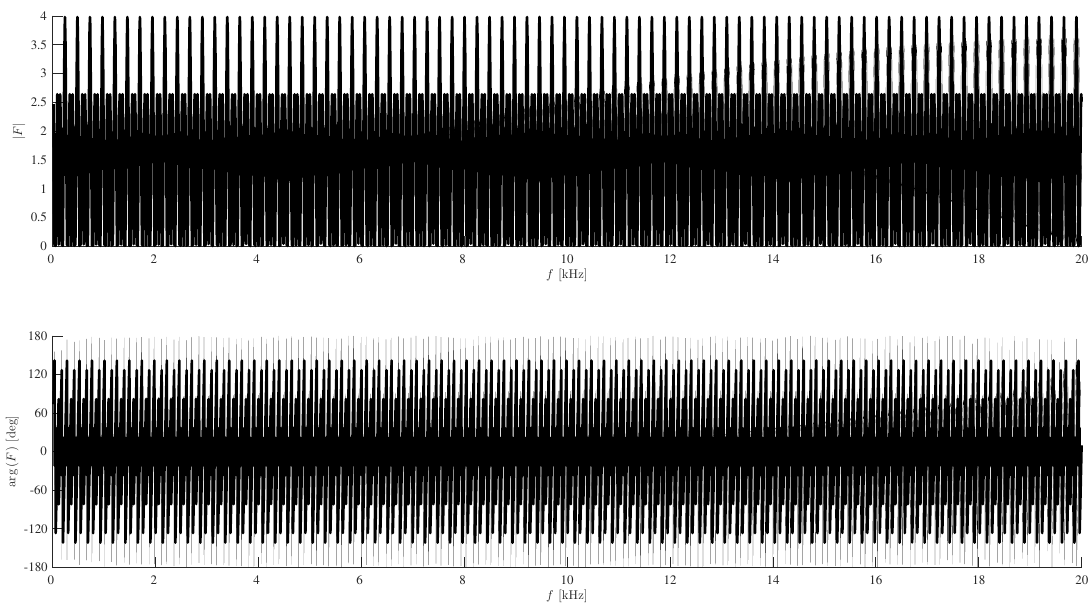
Figure A5: The same as Figure A3 for intermediate source direction, β = 45 °, along the diagonal of the two walls.